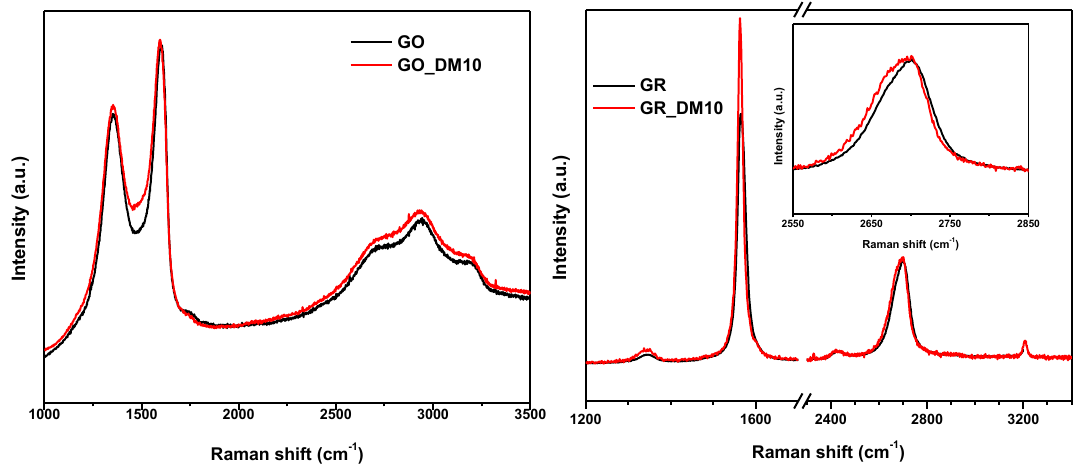
Figure 2. Raman spectra of the hybrid polymeric materials with GO and GR, respectively.